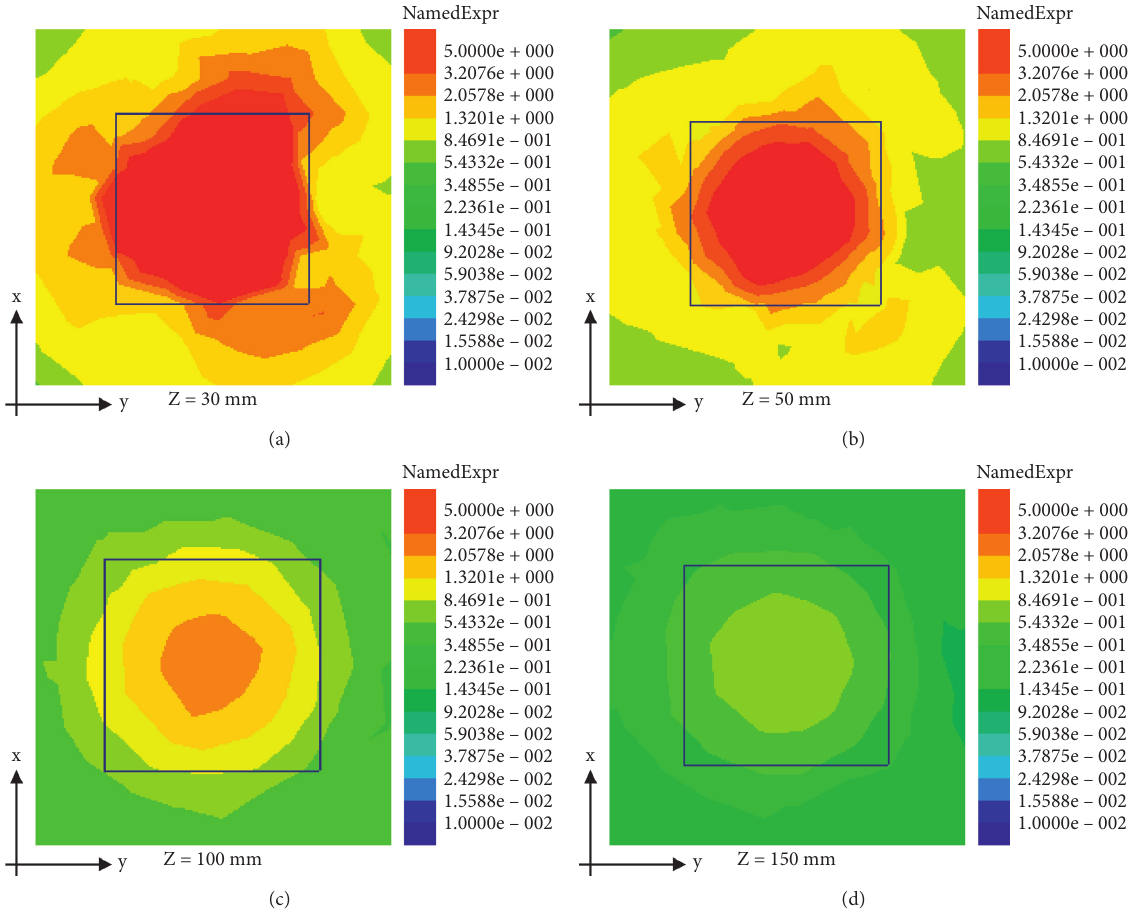
Figure 15: Simulated Ez distributions of the three-branch antenna at different heights when the substrate thickness h � 2.5mm. (a) Z � 30 mm. (b) Z � 50mm. (c) Z � 100mm. (d) Z �